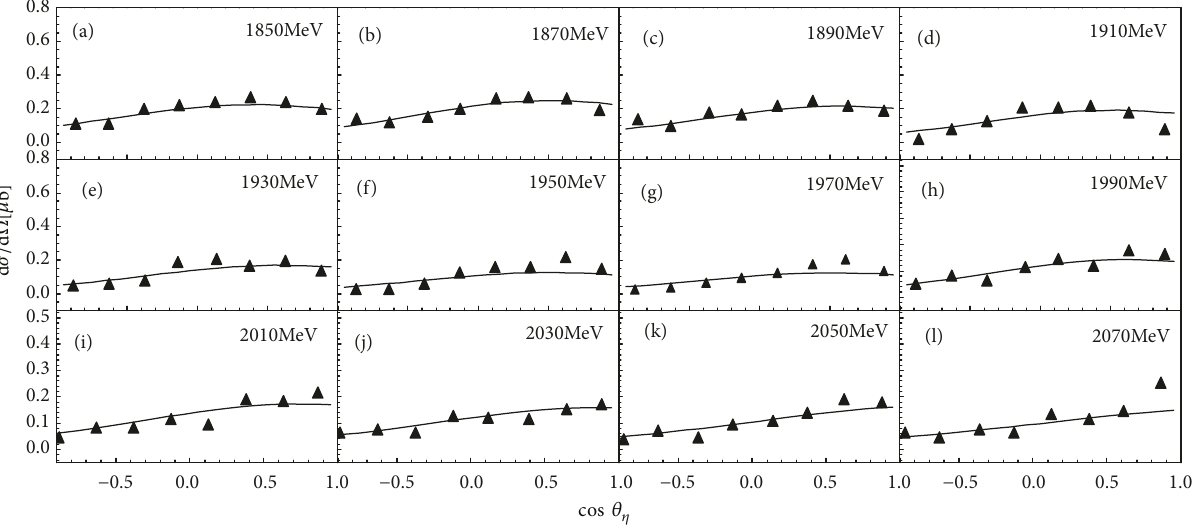
Figure 6: Same as Figure 4, but showing angular distributions for the different bins of final state energy 1850 MeV ≤ 𝑊 ≤ 2070